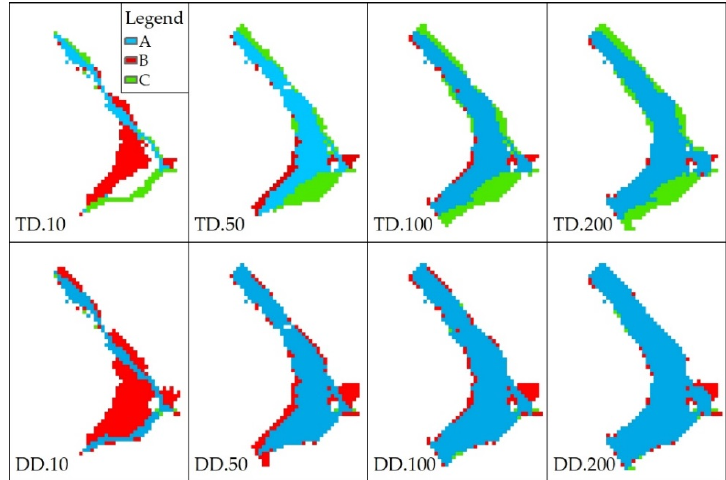
Figure 7. Maps of matching : A, overpredicted: B, and underpredicted: C; areas of simulations from TINITALY (TD-upper panels) and Drone-DEM (DD-lower panels) for the selected return periods–10, 50, 100, and 200 years (left to right panels).